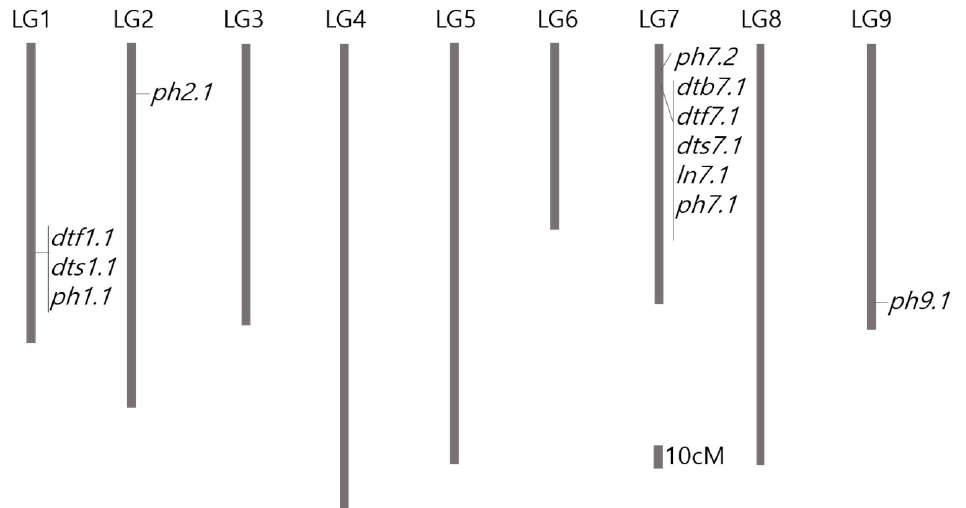
Figure 2. Chromosomal location of QTLs for the number of days from sowing to bolting (DTB), the